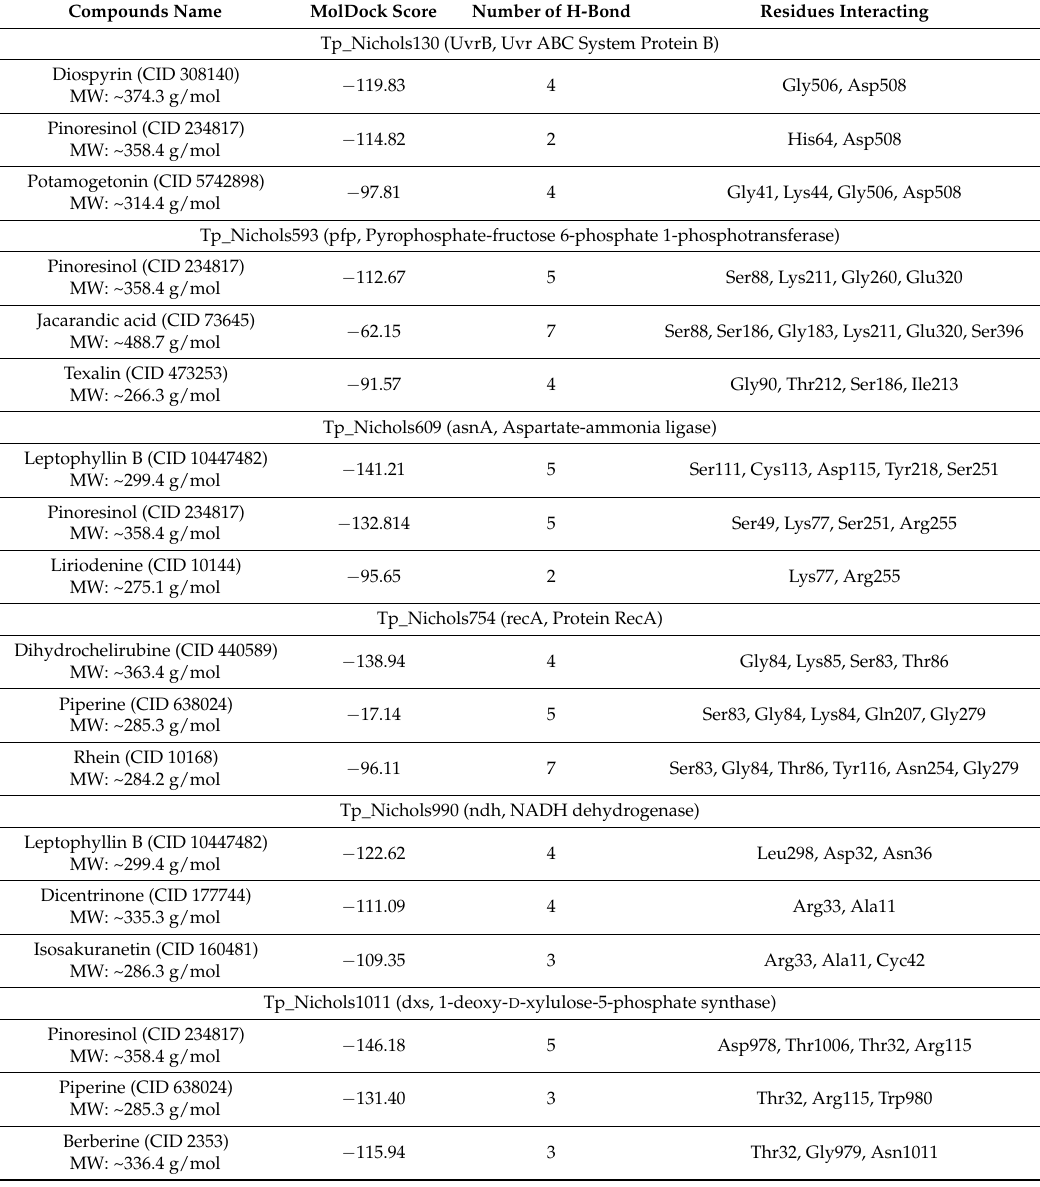
Table 5. The MolDock scores of natural compounds and predicted hydrogen bonds for the selected best-ranked molecules against each drug